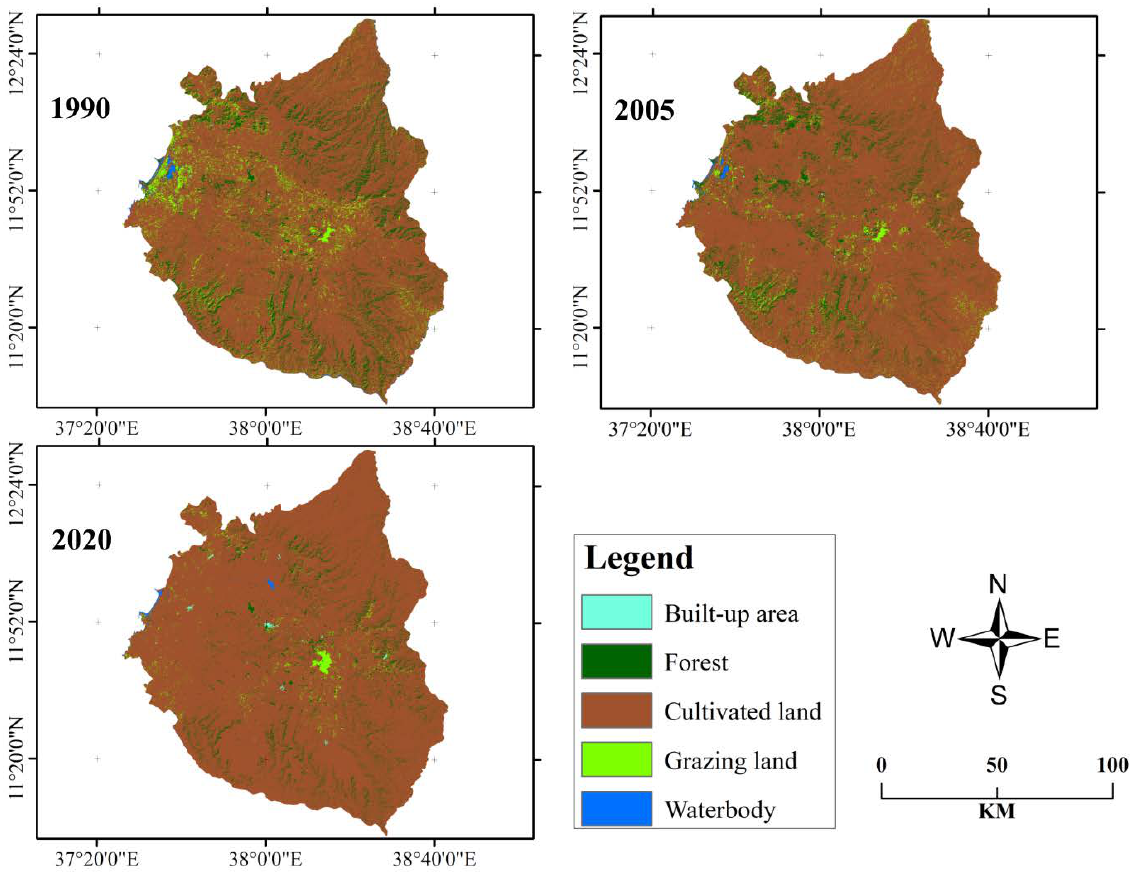
Figure 2. LULC map of South Gondar zone for the years 1990, 2005, and 2020. Table 4. Types of biophysical conservation measures implemented in the SGZ from 2011 to